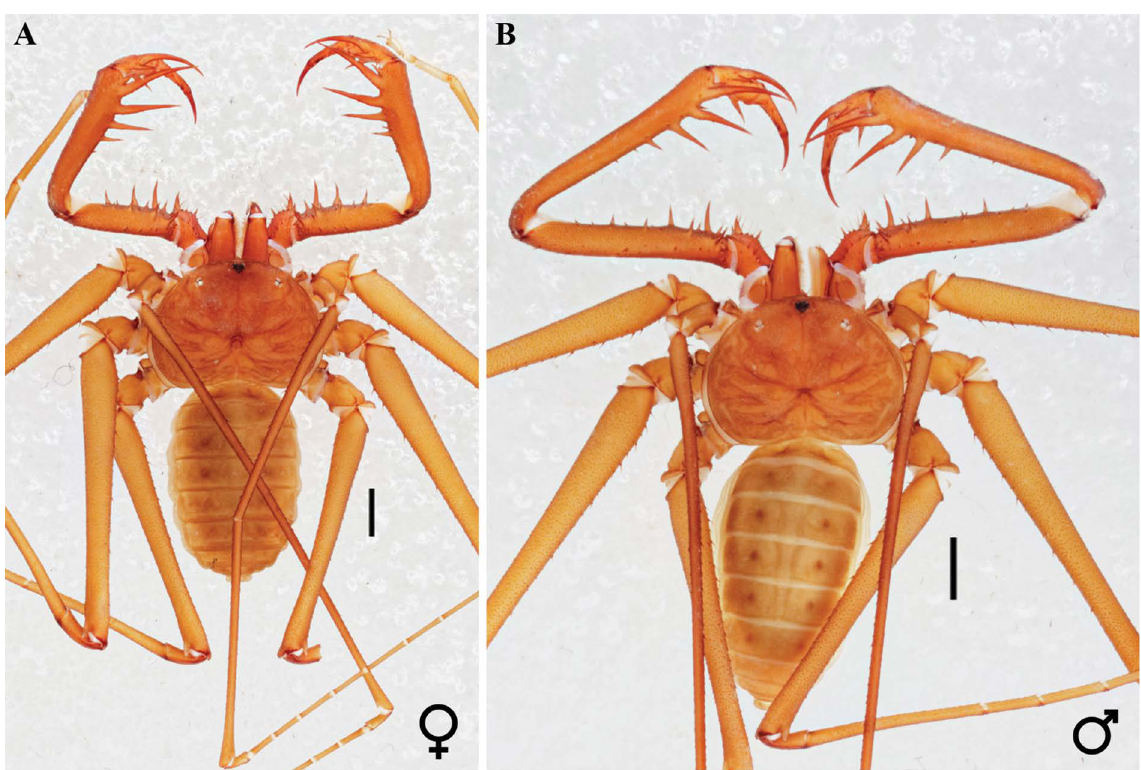
Fig. 53. Charinus carioca sp. nov. (MNRJ 9021), habitus, dorsal view illustrating secondary sexual dimorphism (males possess longer pedipalp segments than females). A . ♀. B . ♂. Scale bars: 1